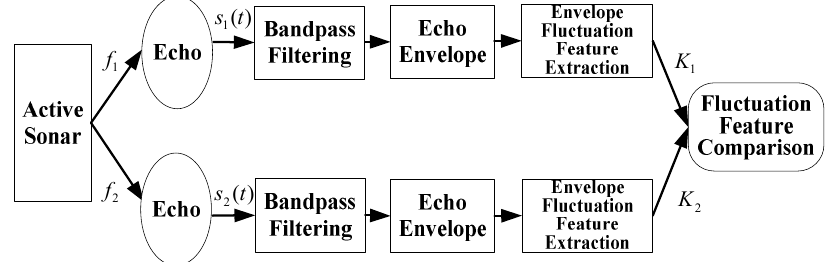
Figure 14. Procedure for discriminating a real underwater target echo from a synthetic echo.